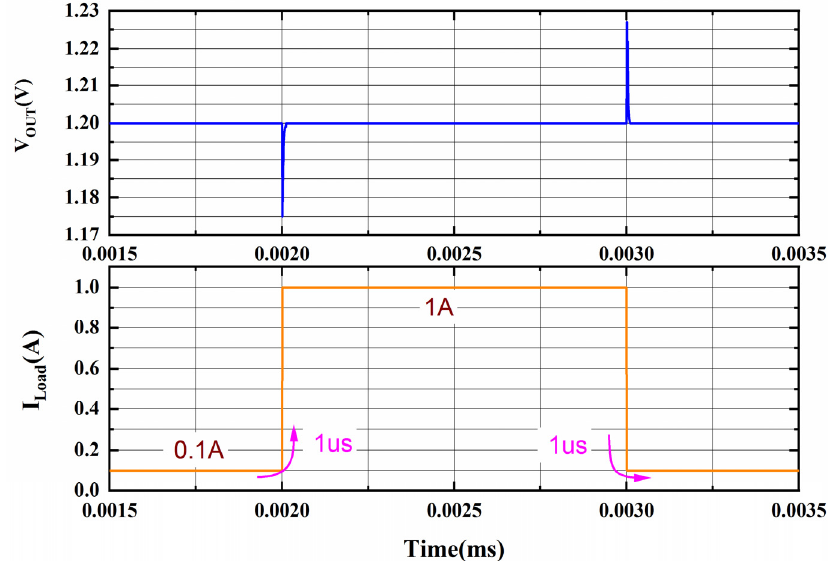
Figure 10. Simulated load transient response with 900 mA/ μ s.